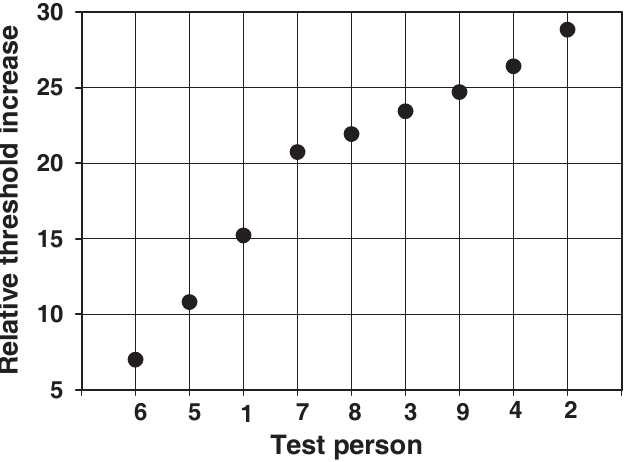
Figure 3. Ratio of the maximum value of the discrimination threshold to the initial threshold at − 0.5 s for all subjects (ordered by the magnitude of the